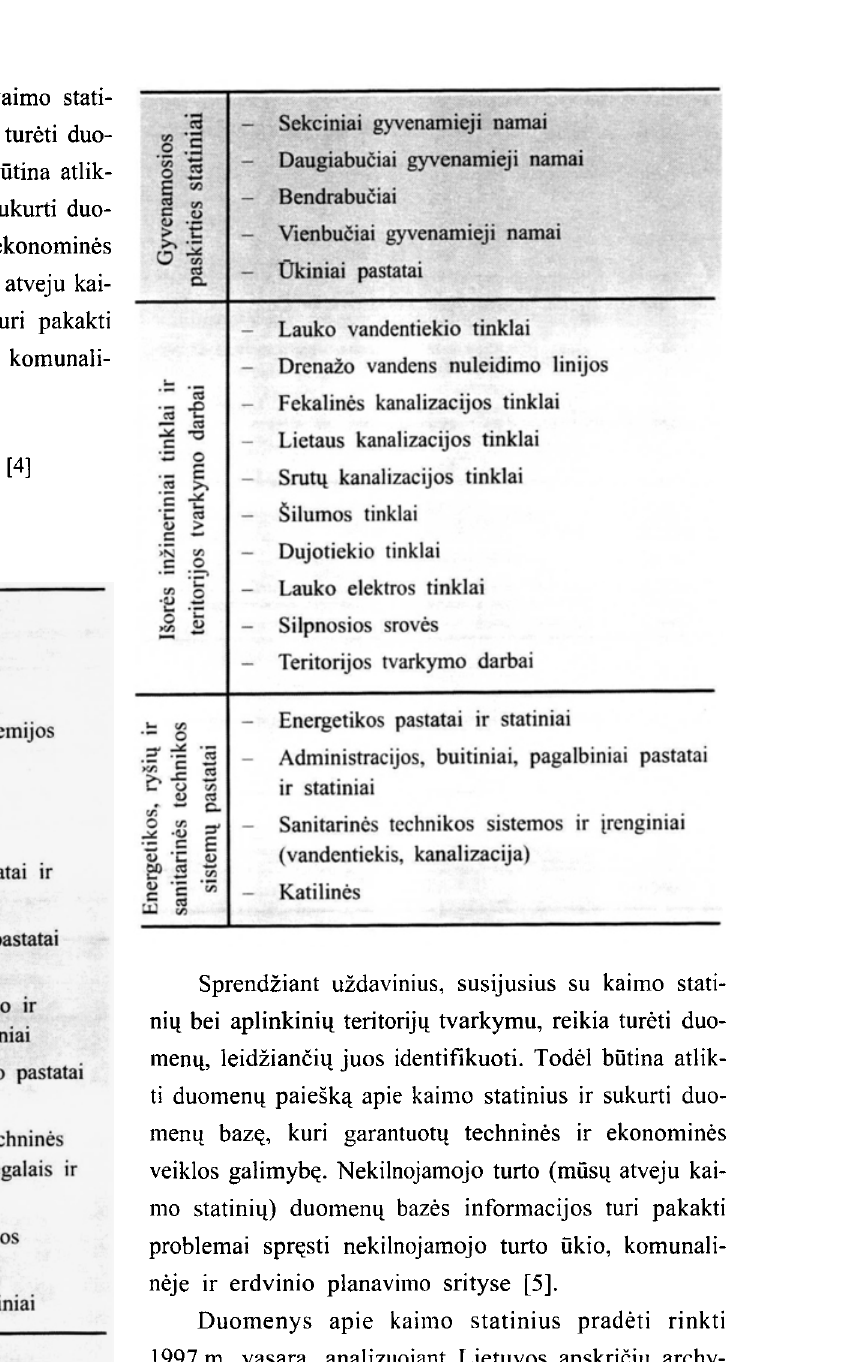
Table 1. Classification of rural property [4]